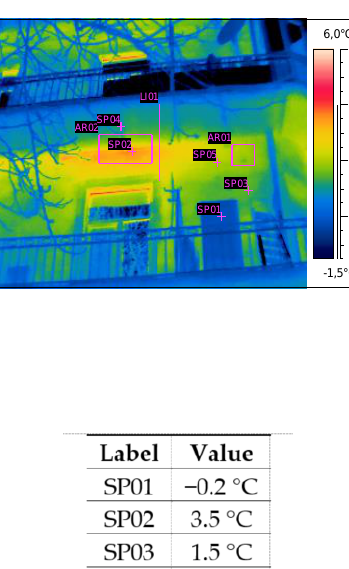
Figure 9. Frontal facade thermovision diagnostics with measurements.